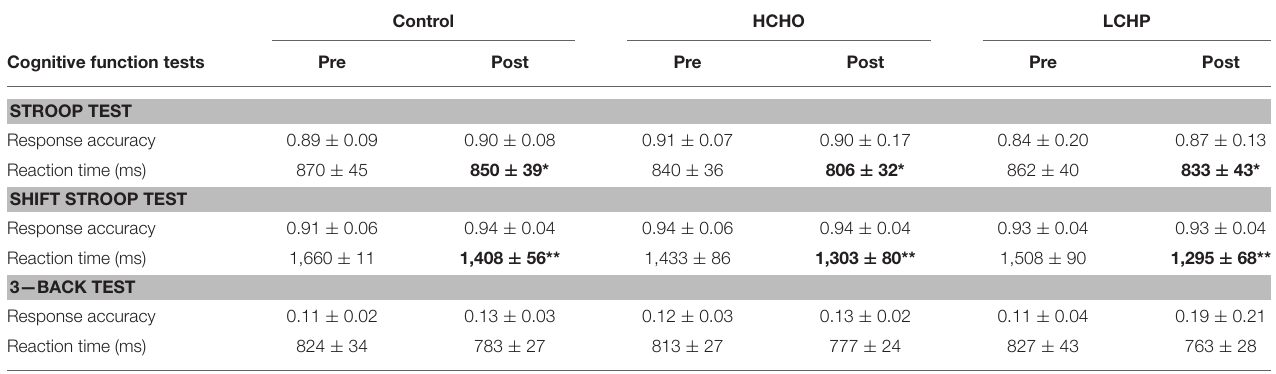
TABLE 2 | Cognitive function results.